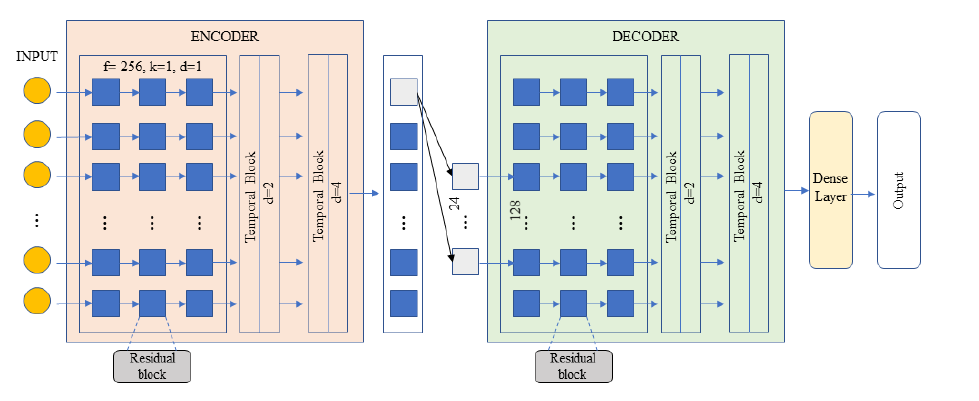
Figure 2. The framework of the proposed MH-ED-TCN illustrates how data collected x ( ∆ ) from the 3D printer is fed into the system is will be the sequenced. The variables f, k, and d stand for the filter count, filter size, and dilation factor,